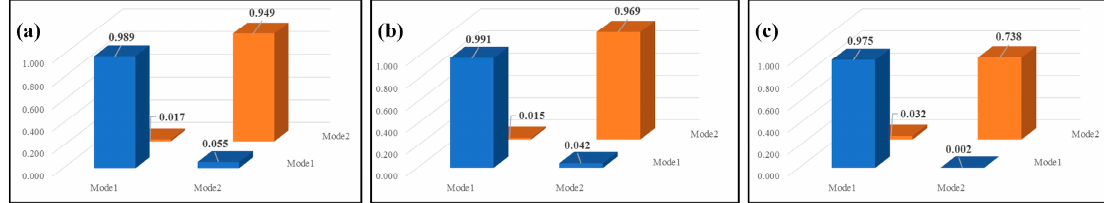
Figure 10. Modal assurance criterion analysis results between analytical model and experimental value; ( a ) MIDAS and LDS; ( b ) MIDAS and NVDS; ( c ) MIDAS and VDS.